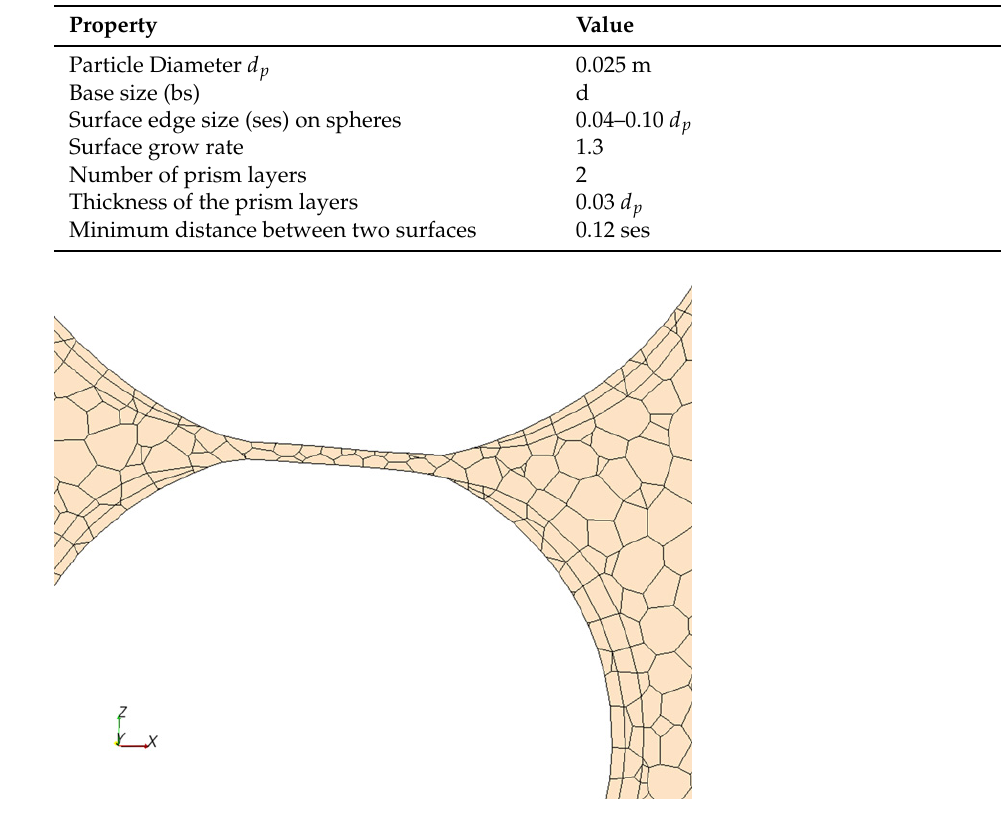
Figure 1. Local flattening at the contact point of two spherical particles.